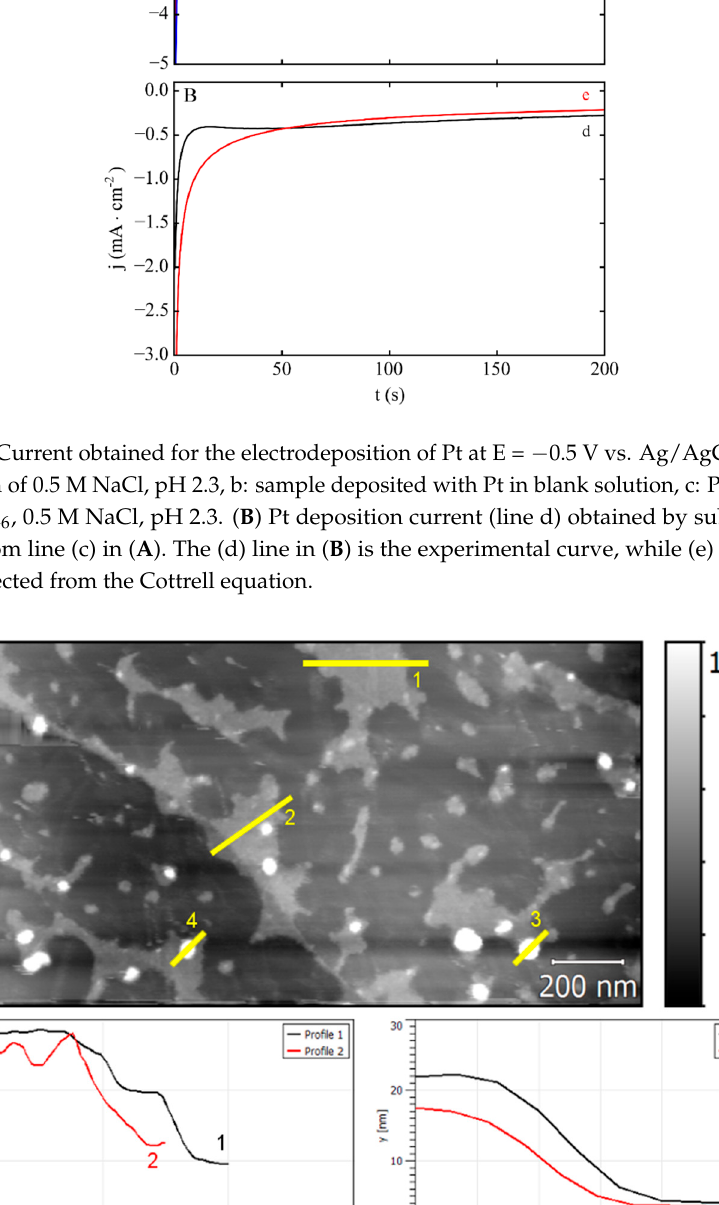
Figure 10. AFM image of a sample electrodeposited at − 2 V vs. Ag/AgCl showing the radial profiles measurements of the two populations of deposited structures.